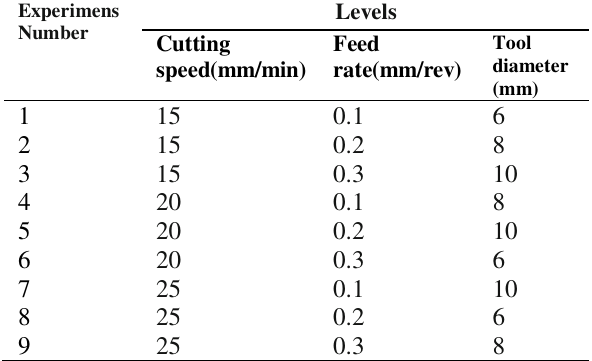
Control Factors Using “Orthogonal